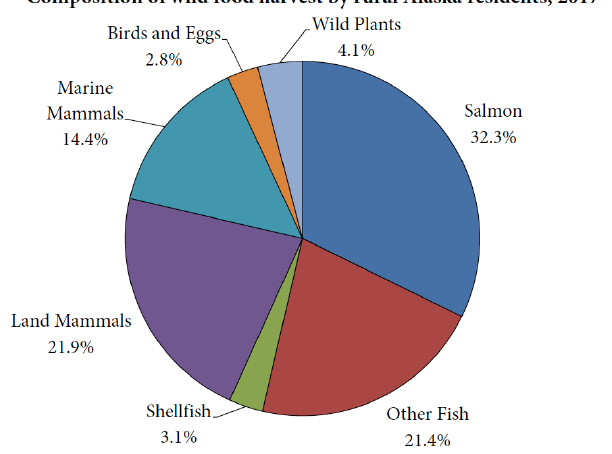
Figure 3. Wild food harvest in rural Alaska